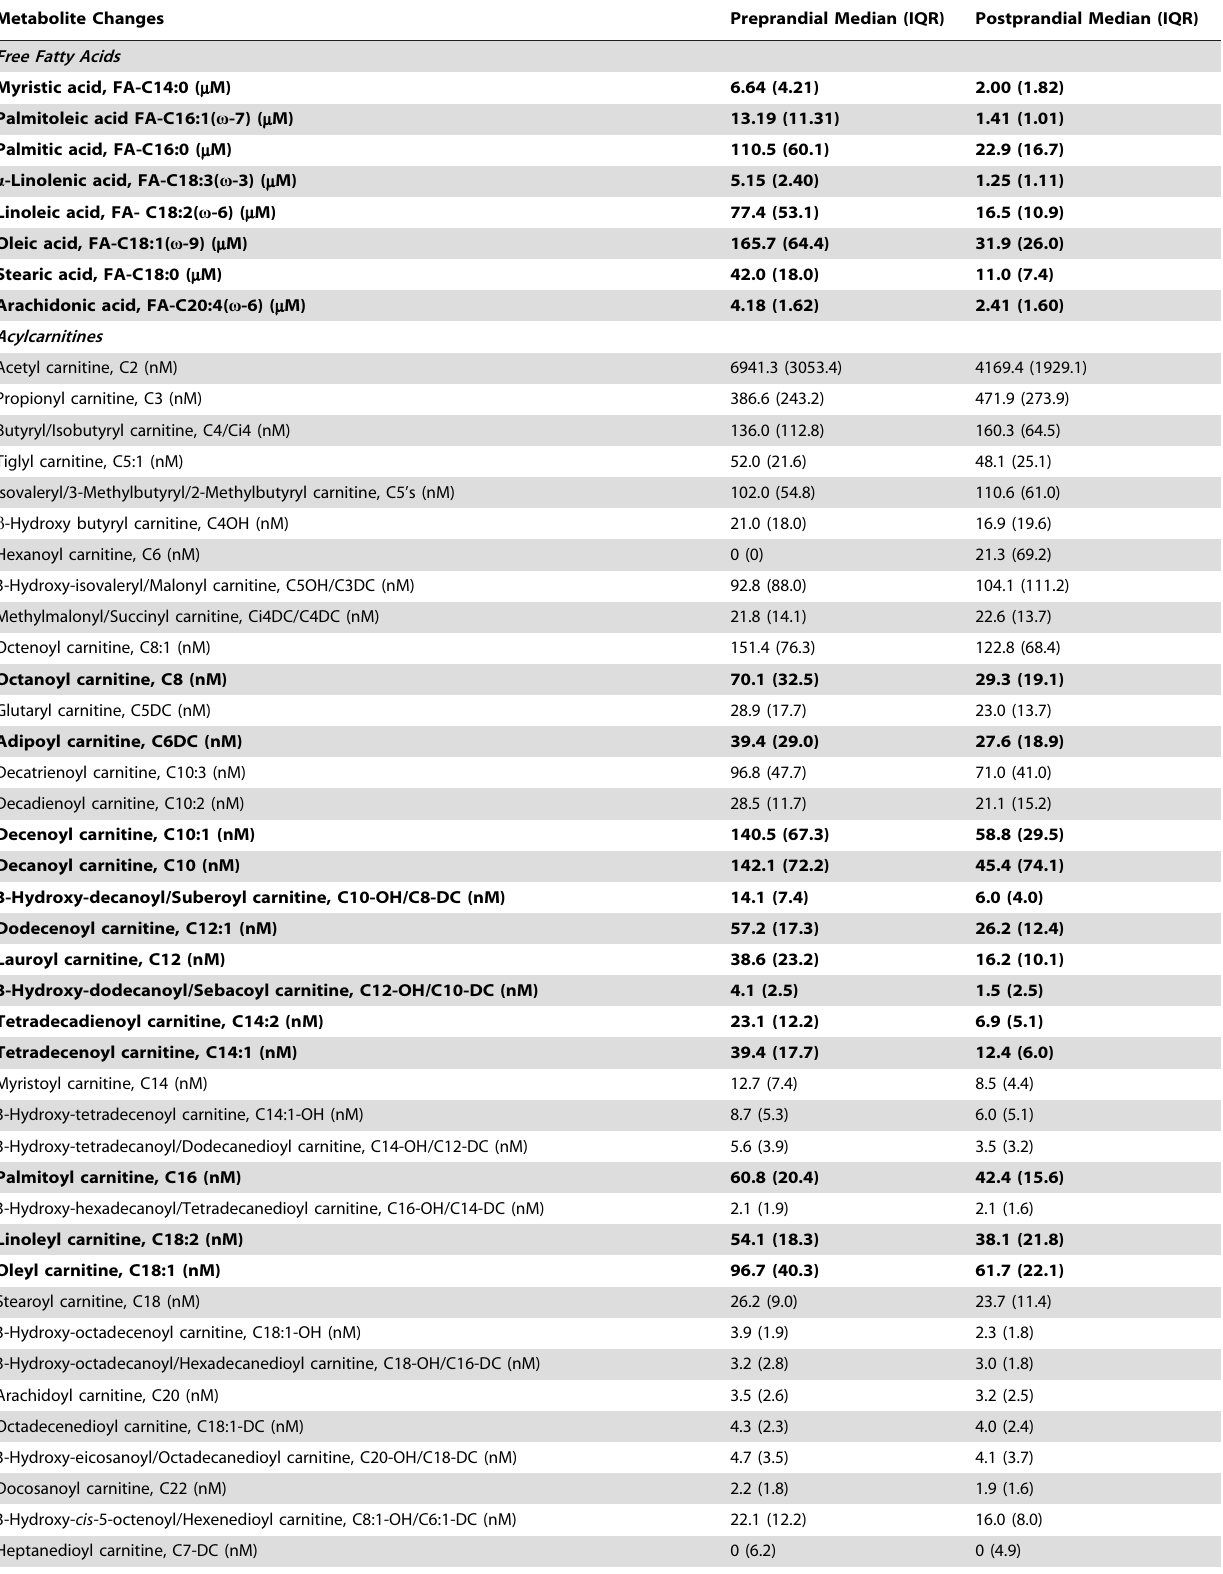
Table 2. Median and interquartile range (IQR) of fasting and postprandial concentrations of metabolites at baseline